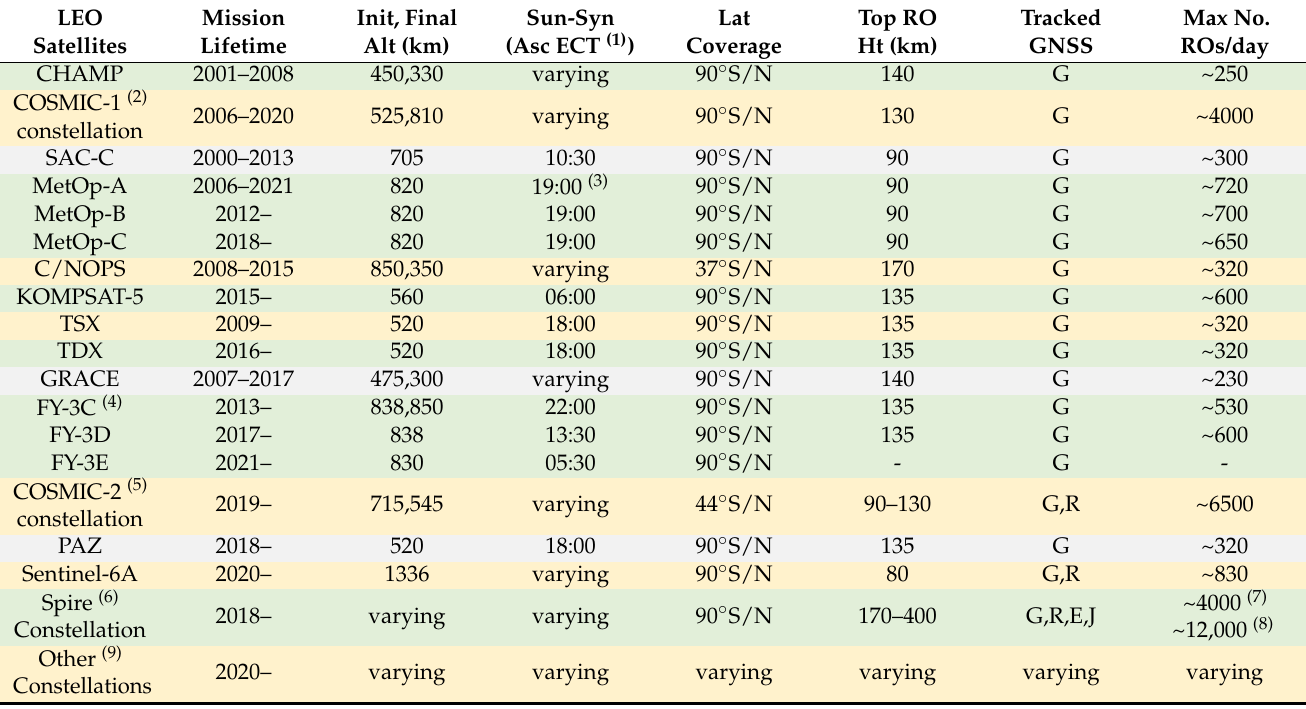
Figure A2. Number of daily GNSS-RO profiles since the CHAMP mission. Recent rising numbers are mainly from the COSMIC-2 and Spire constellations. The Spire RO numbers are based on the data archived under NASA’s CSDA program. Table A1. Summary of GNSS-RO data in this